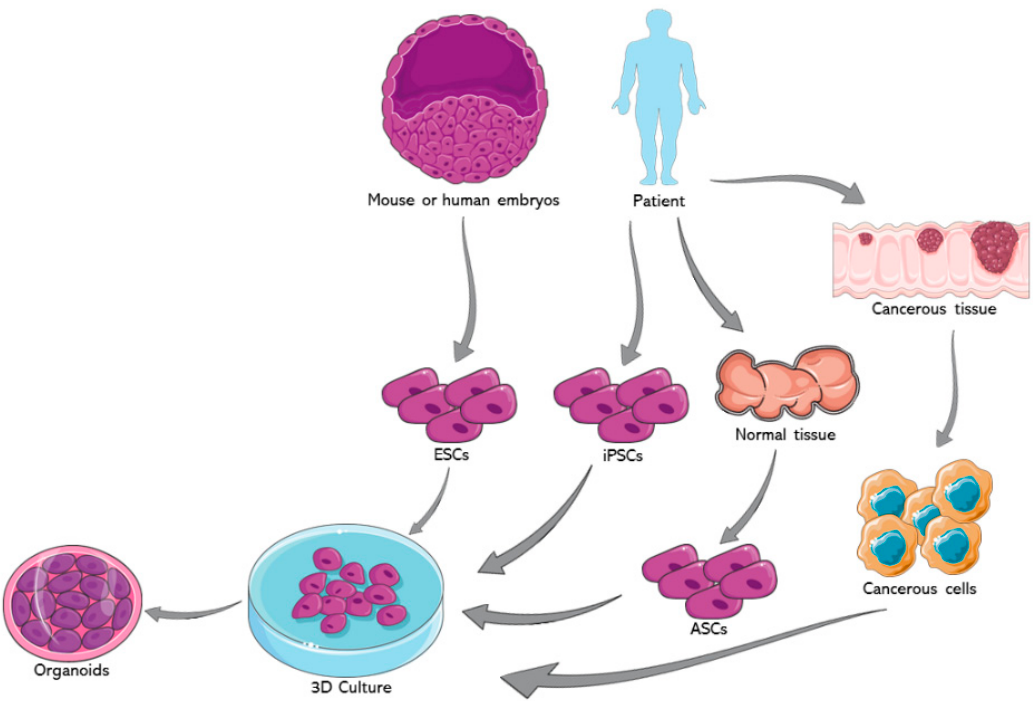
Figure 1. Organoids generation from different types of stem cells. Organoids can be generated from induced pluripotent stem cells (iPSCs), embryonic stem cells (ESCs) and patient-derived adult stem cells from normal and cancerous tissues (ASCs). Cells are usually grown in three dimensional systems under specific conditions to stimulate the growth of organoids. Shapes and images are imported from Servier Medical Art by Servier (http://smart.servier.com/), accessed on 24 May 2021. Licensed under a Creative Commons Attribution 3.0 Unported License (https://creativecommons.org/li- censes/by/3.0/).